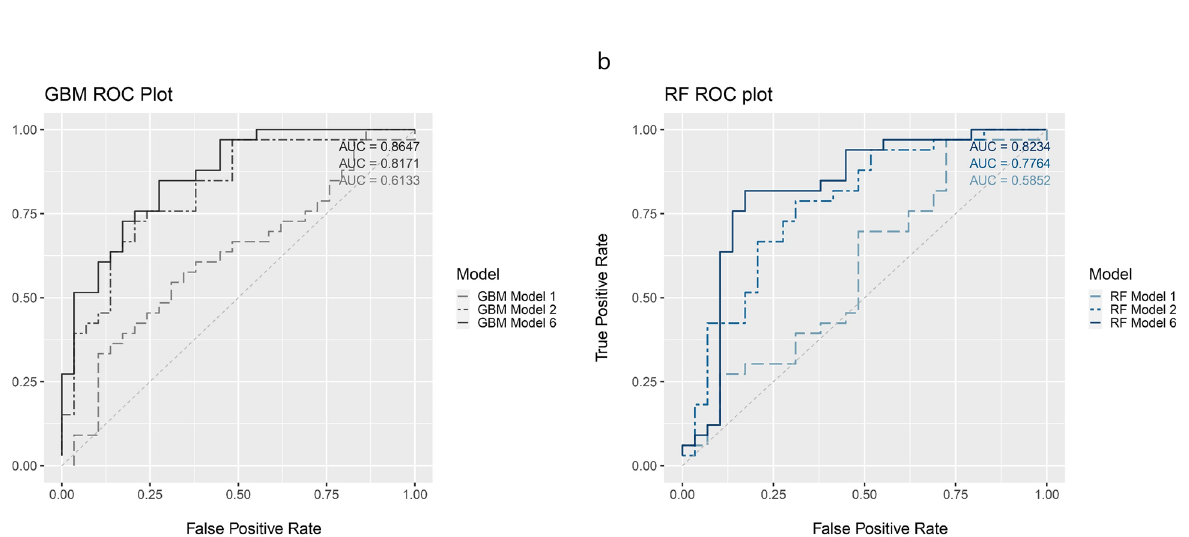
Figure 1. The ROC curve of the proposed method ( a ) GBM ( b ) RF. ROC receiver operating characteristic, AUC area under the curve, GBM gradient boosting machine, RF random forest. model 1 = Baseline